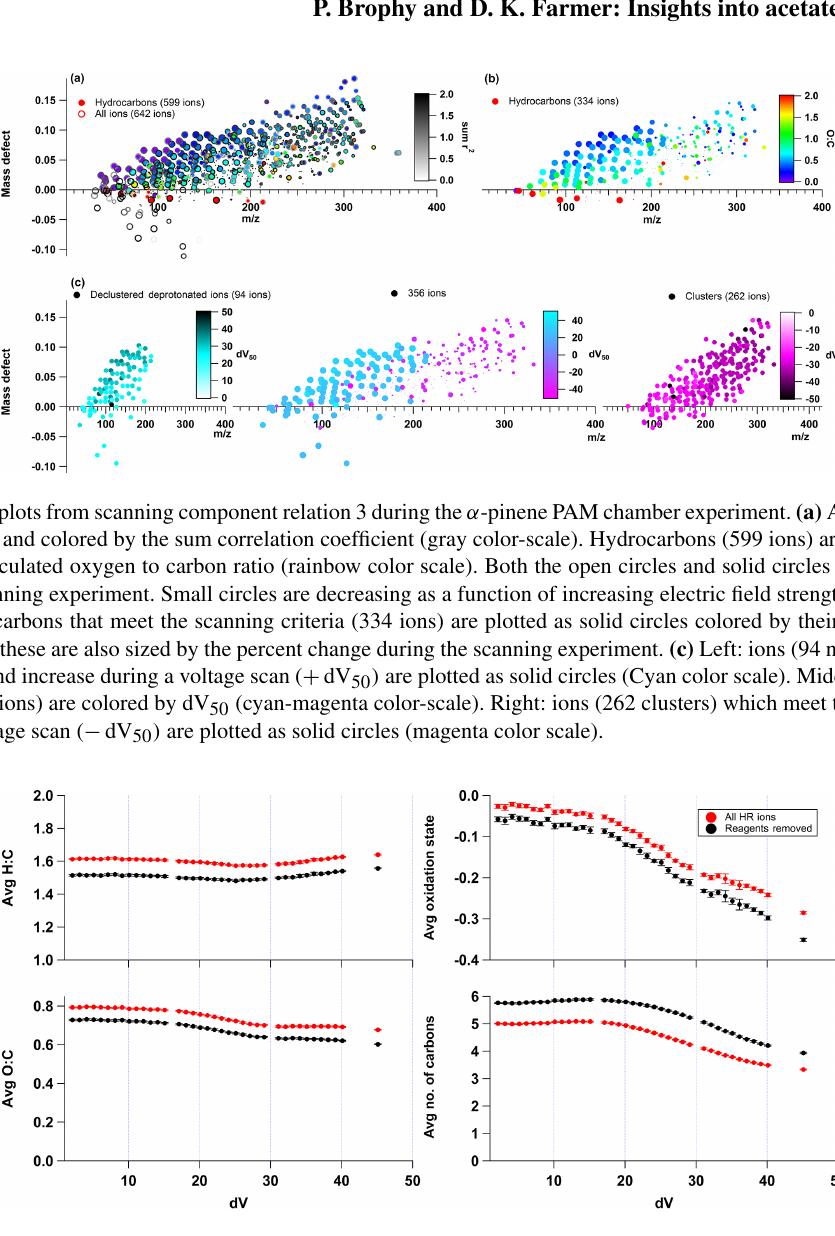
Figure 10. Bulk properties calculated in Tofware during the α -pinene PAM chamber experiment are plotted as a function of dV (component relation